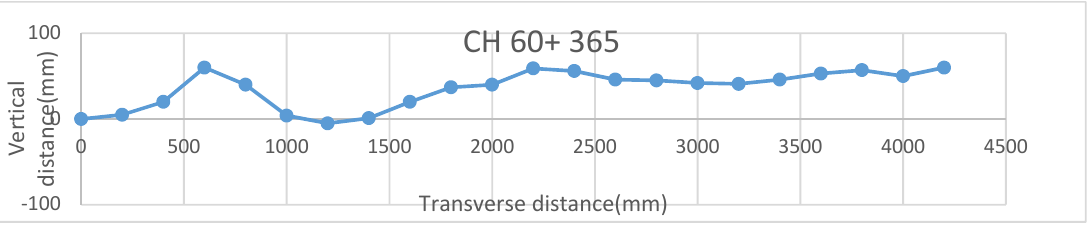
Figure 10. Transverse profile of 60 + 365 km.